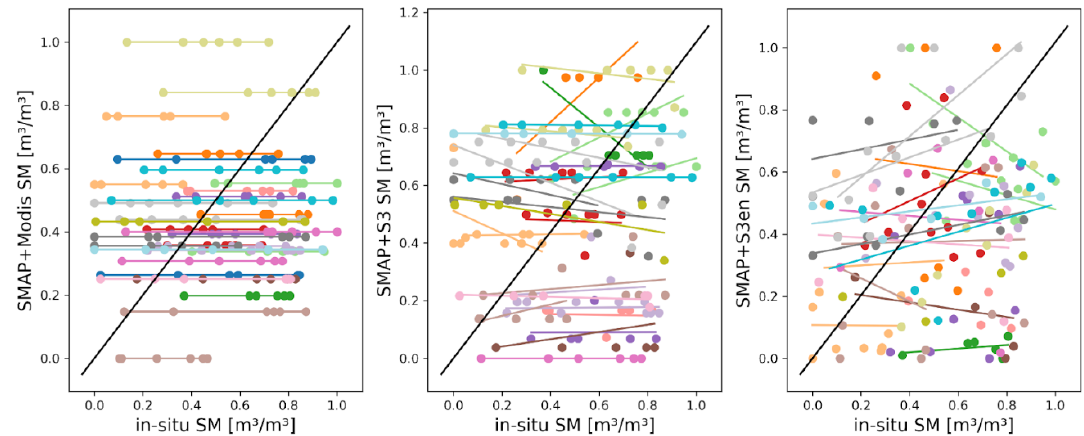
Figure 7. Spatial analysis for the field in Raimat. ( a ) Footprints of the different pixel sizes of the product used. For the case of SMAP + MODIS (pink), a single pixel covers the entire area, showing the same value for the six different sensors, while in the case of SMAP + S3 (cyan) the sensor in position P7 is covered by a different pixel. SMAP + S3en (yellow) has a finer resolution where each pixel covers a different sensor. The six points representing the sensors’ positions have been magnified for the sake of visibility, each of them is actually contained in a 20 m by 20 m SMAP + S3en pixel. ( b ) Spatial correlation for each available day for the 3 different products, SMAP + MODIS, SMAP + S3 and SMAP + S3en.